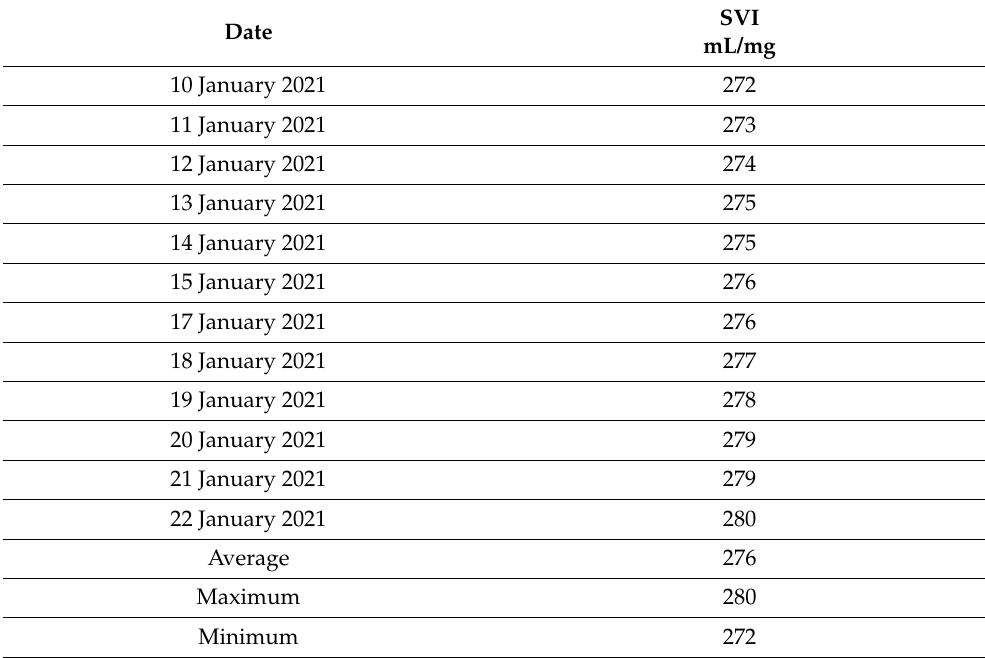
Table 8. SVI values for respective sampling day at plant